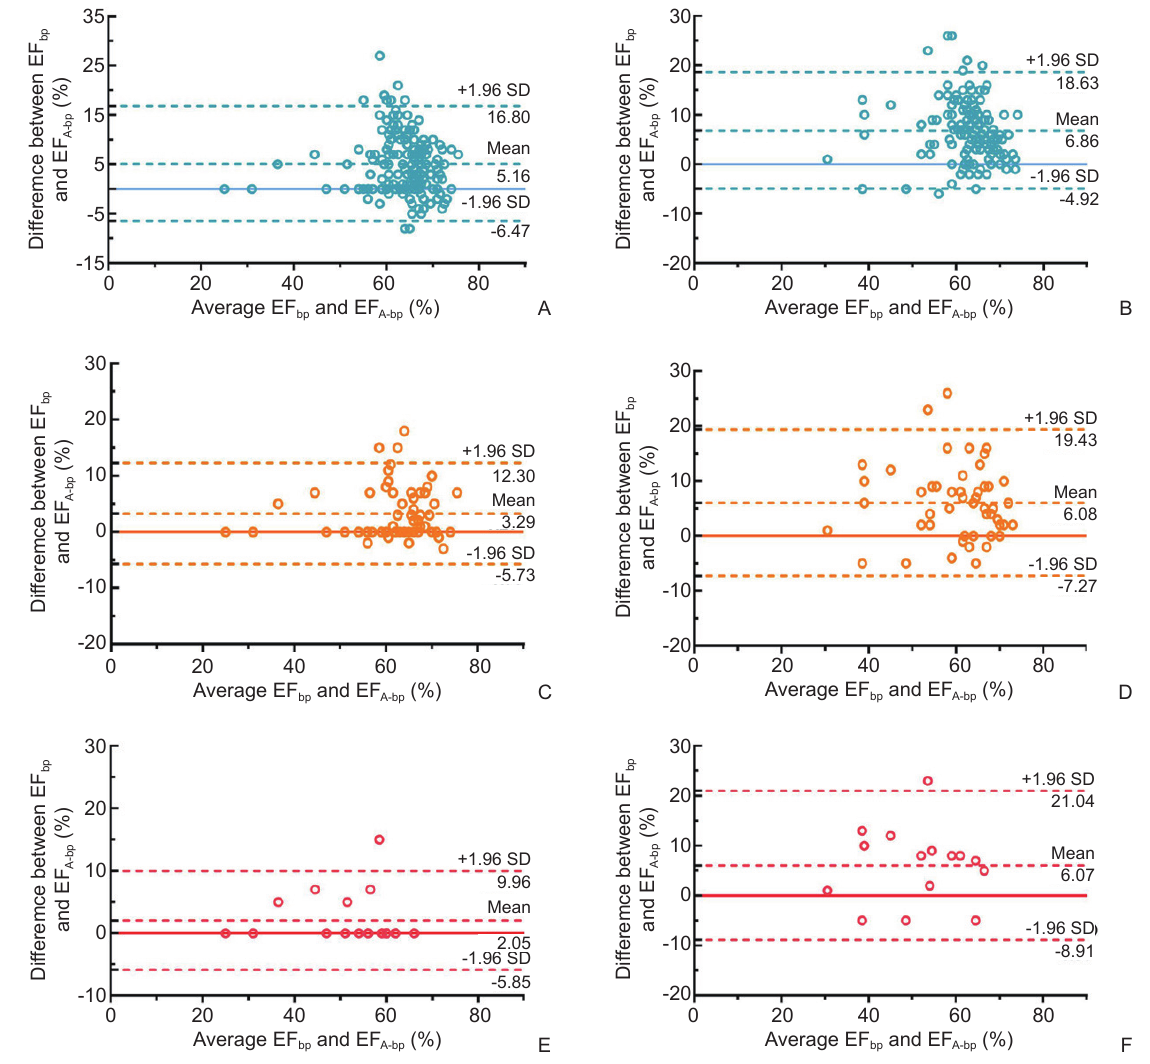
Figure 5 Bland–Altman analysis of EF between different methods in different image quality group. (left) The good quality group and (right) poor quality group for manual EF vs. automated EF in the common group (A and B), CHD group (C and D), WMA group (E and F). CHD, cardiac heart disease; WMA, wall motion abnormalities; EF, ejection fraction; EF bp was parameter by manual method; EF A-bp was parameter by automated method. Table 3 ICC analysis for manual vs automated method in different image quality group